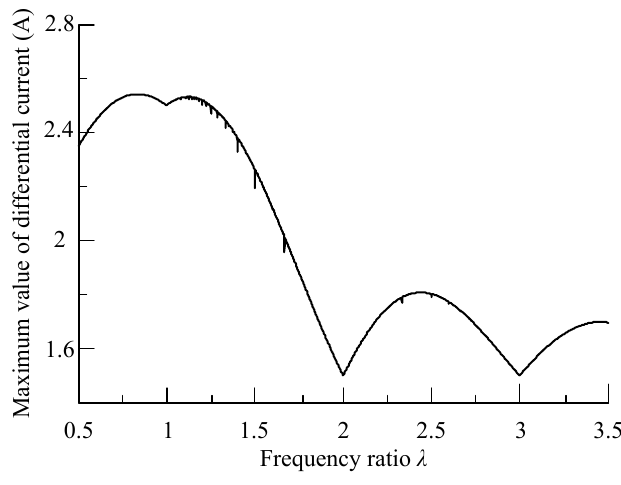
Figure 11. Maximum amplitude characteristics of a differential